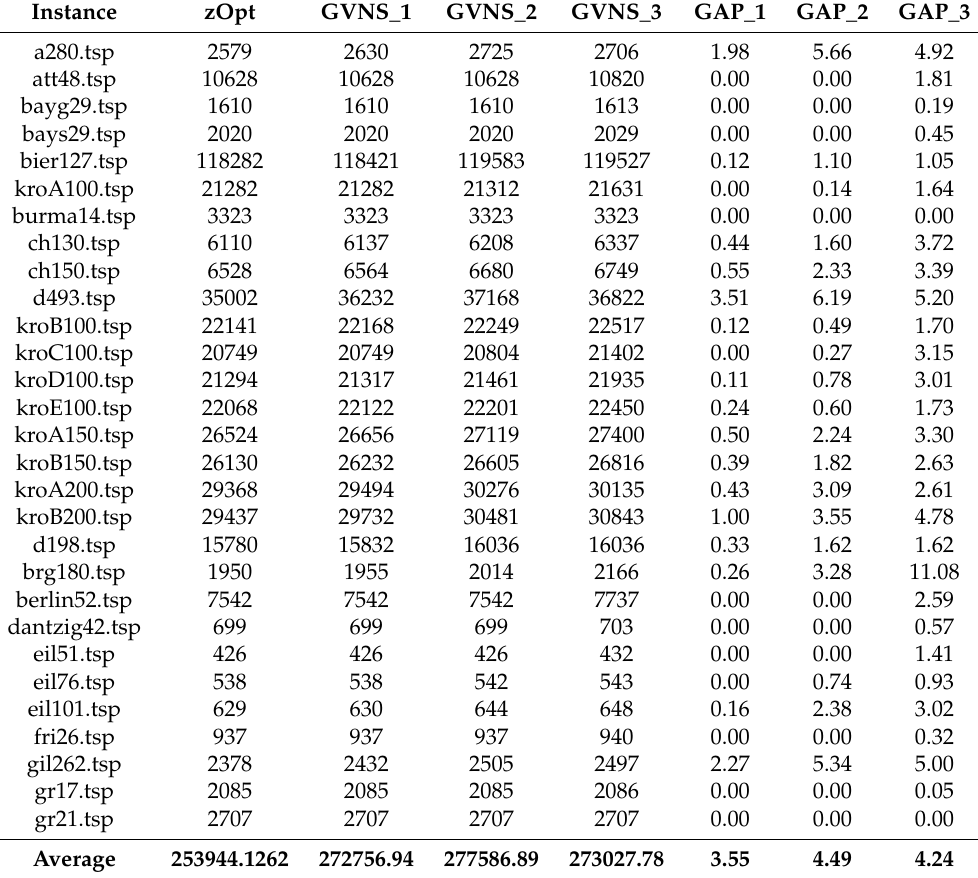
Table 8. Results using the Best Improvement search strategy and an execution time limit of 2